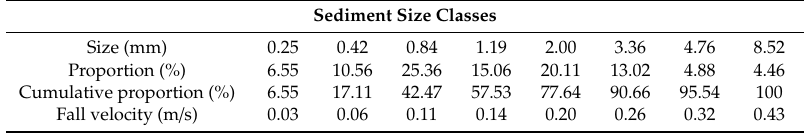
Table 1. Sediment characteristics of the experiments that were applied in the numerical